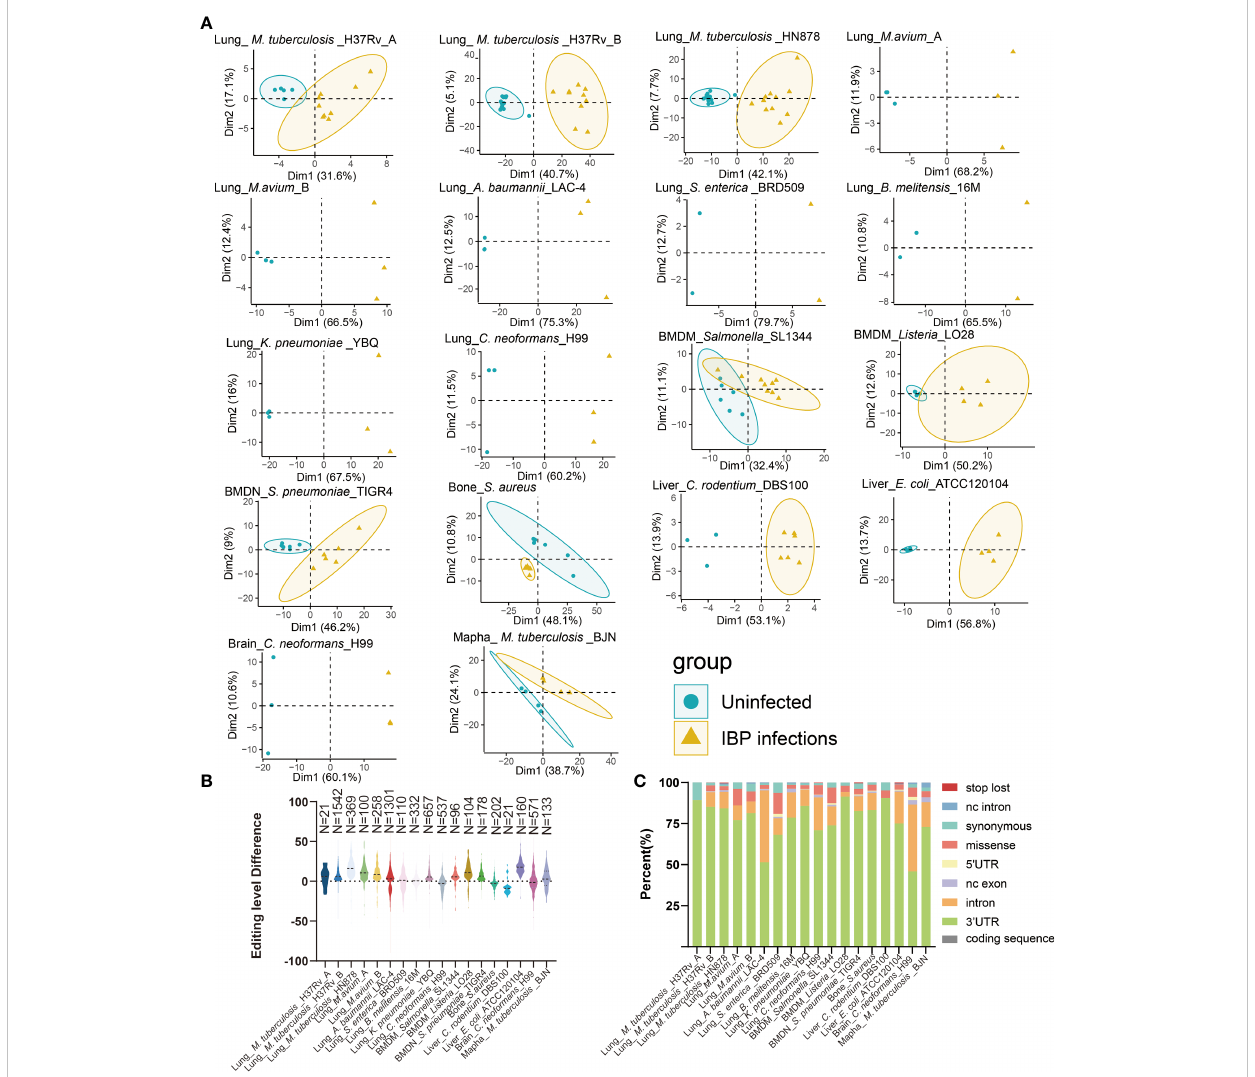
FIGURE 1 Altered A-to-I RNA editing pro fi les during IBP infections (A) First two principal components of differential editing pro fi les reveal the difference in RNA editing patterns between the uninfected and infected groups. (B) The difference in editing levels between infected and uninfected samples in IBP infections. The number of DRE sites is listed at the top of the plots. (C) The functional categories of DRE sites in IBP infections. nc intron: non coding transcript intron variant, nc exon: non coding transcript exon